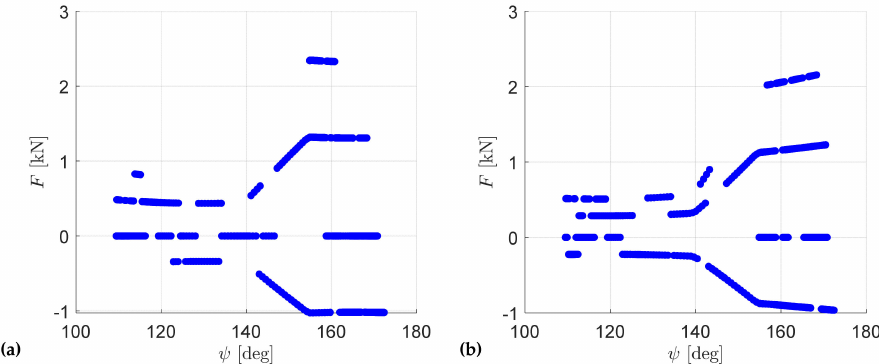
Figure 15. Forces (positive being compressive, negative being tensile) acting on the connecting rod linkages: ( a ) mechanism 1; ( b ) mechanism